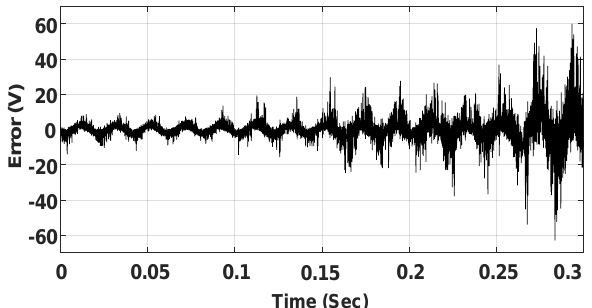
Figure 5. Simulation result for the (SP-CMPC): instantaneous voltage error during sweeping the weighting factor λ sw in the same manner as the above figure using the CF in Equation (21) with the conventional tracking